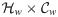
ITQ-based model-data comparison at site scale for Mediterranean flux tower sites.(A) Hw×Cw, and (B) Hw×Fw. (C) Time series of GPP at Puechabon, France.